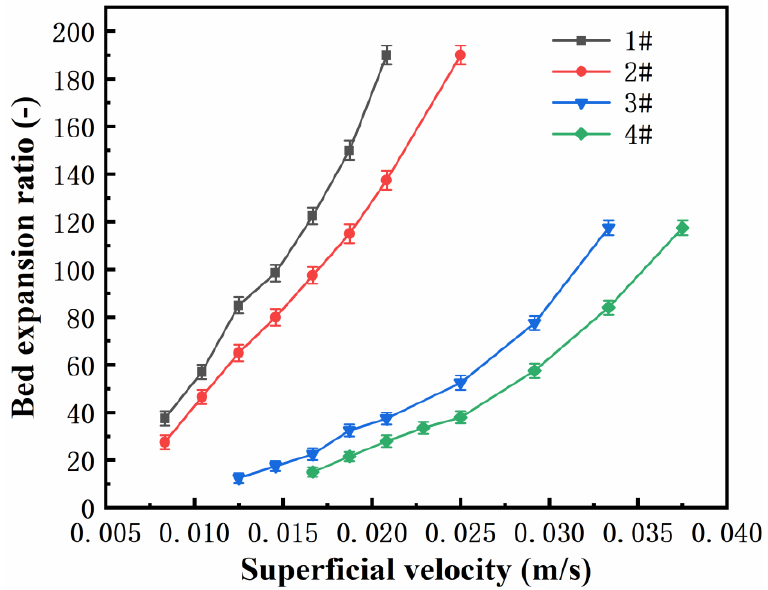
Figure 2. The bed expansion ratio at different superficial velocities for the various samples 1#, 2#, 3#, and 4#.